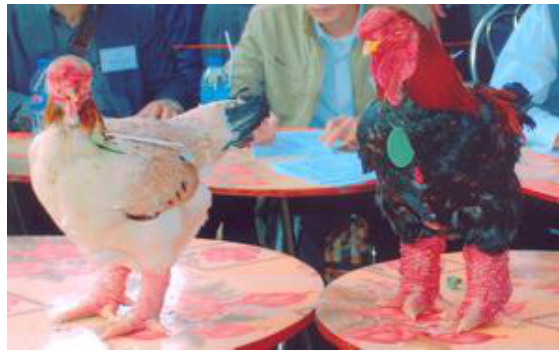
Figure 1. Adult female (right) and male (left) Ho chickens.